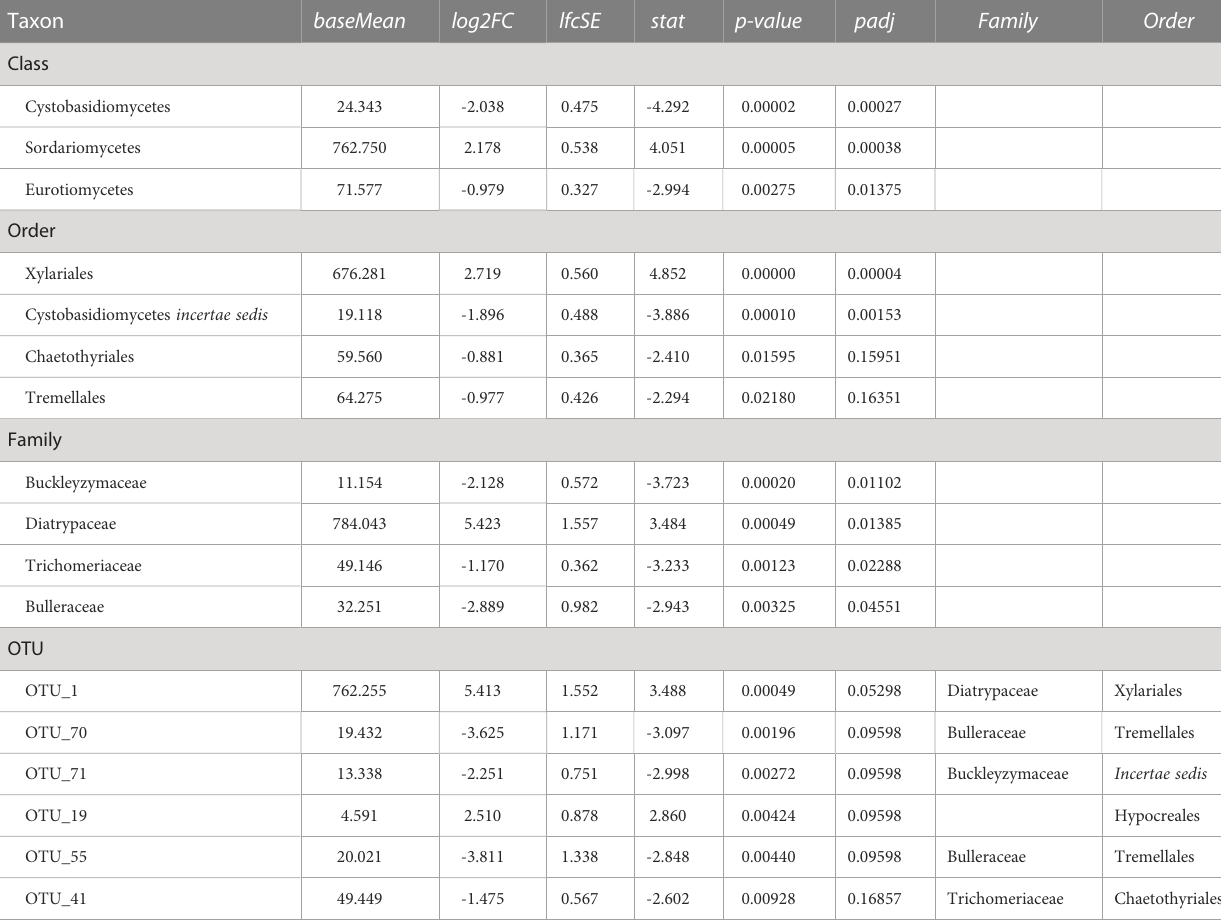
TABLE 2 Taxa with signi fi cant positive or negative associations ( padj < 0.1; p-value < 0.05 for OTUs) with resistance to